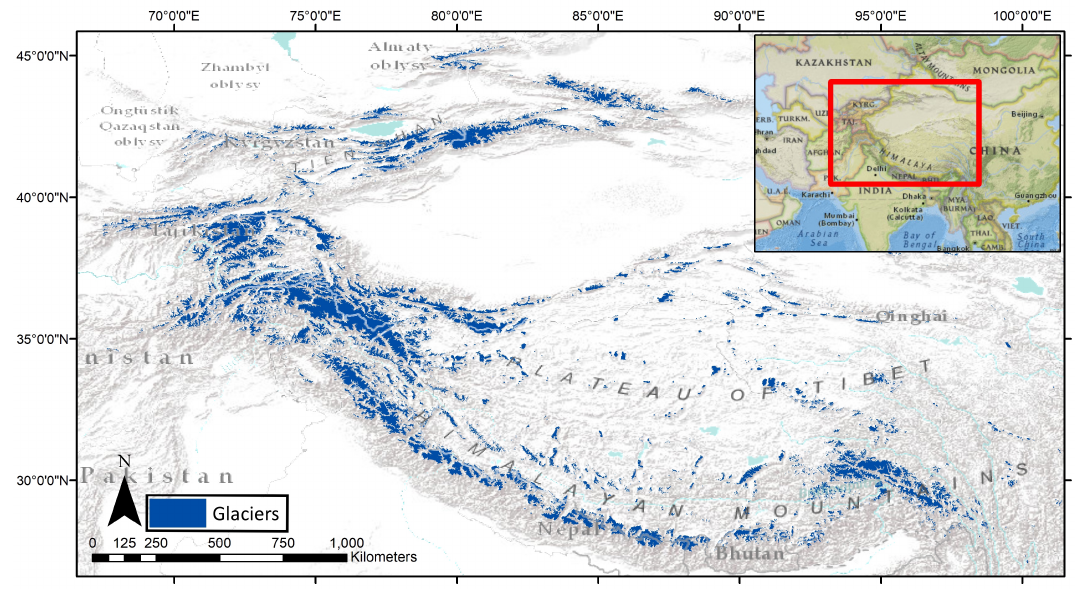
Figure 1. The High Mountain Asia region with glaciers shown in blue. Many of these glaciers have debris mantles [4,38,40,41]. Glacier outlines were acquired from the GLIMS (Global Land Ice Measurements from Space)